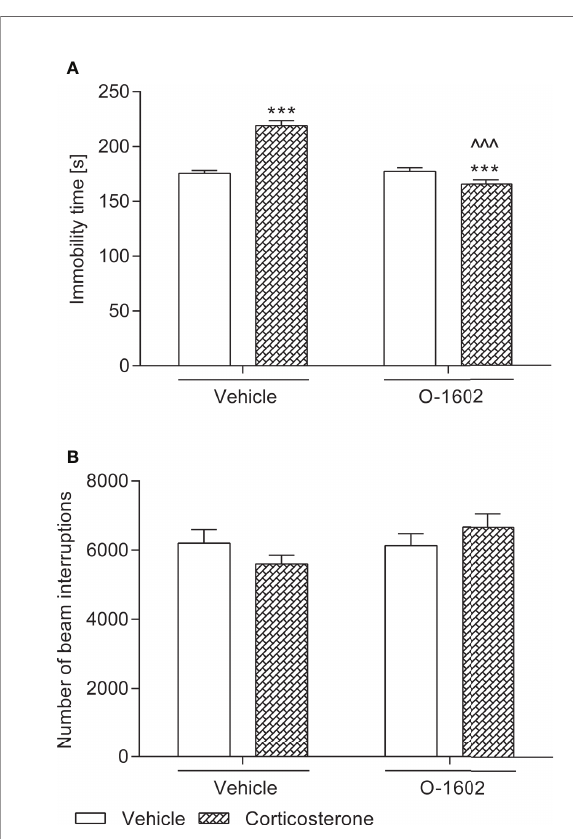
FIGURE 1 | In fl uence of the 7-day intravenous administration of O-1602 (0.25 mg/kg/day) on the behaviour of rats subjected to the 14-day corticosterone treatment (20 mg/kg/day, subcutaneously) (A) in the forced swim test and (B) in the measurement of locomotor activity. The values represent the mean+SEM (n=12 animals per group). ***p<0.001 versus vehicle-treated group, ^^^p<0.001 versus corticosterone-treated group (Bonferroni ’ s post hoc